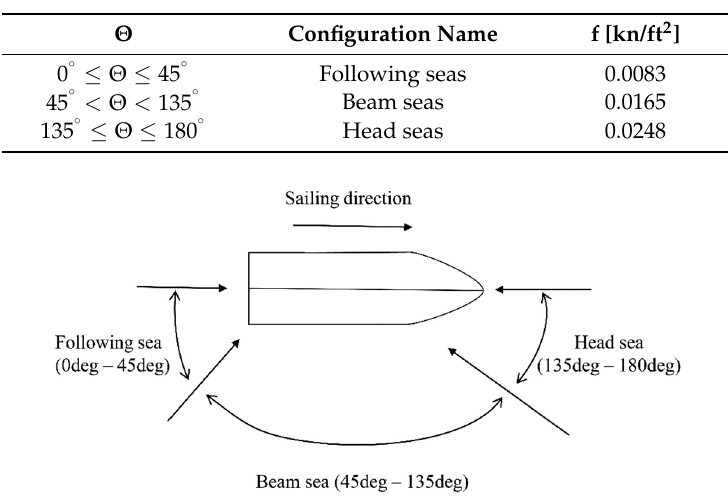
Figure 2. The ship-wave relative direction.